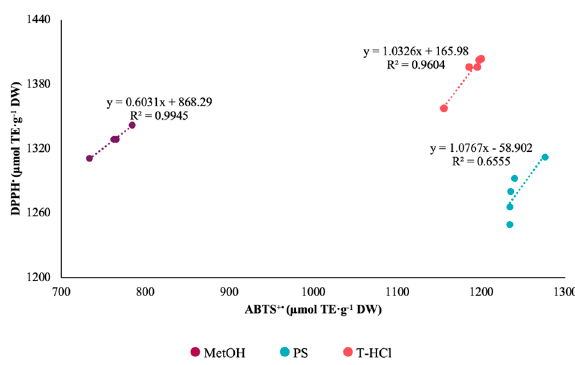
Figure 3. Pearson’s correlation of FRAP and ABTS + • assays of MetOH, PS, and T-HCl extracts.